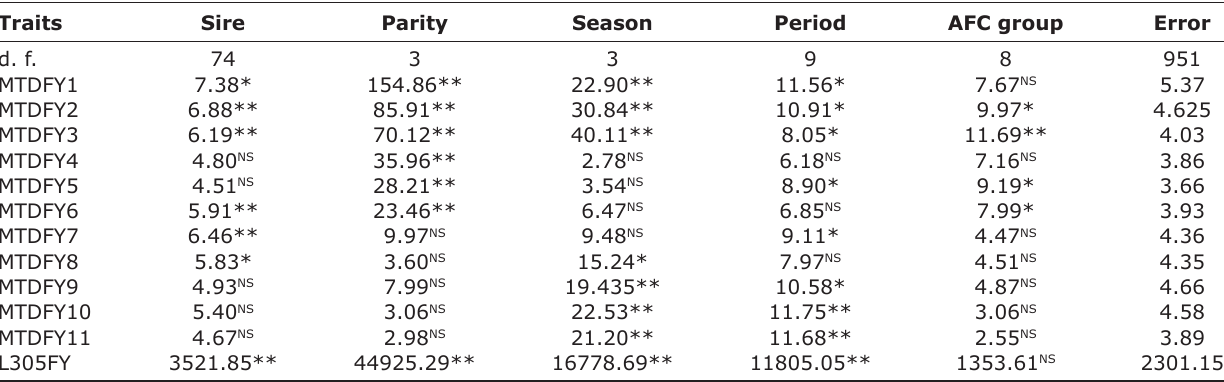
Table-2: Mixed model ANOVA showing mean sum of squares for factors affecting MTDFY and L305FY. Traits Sire Parity Season Period